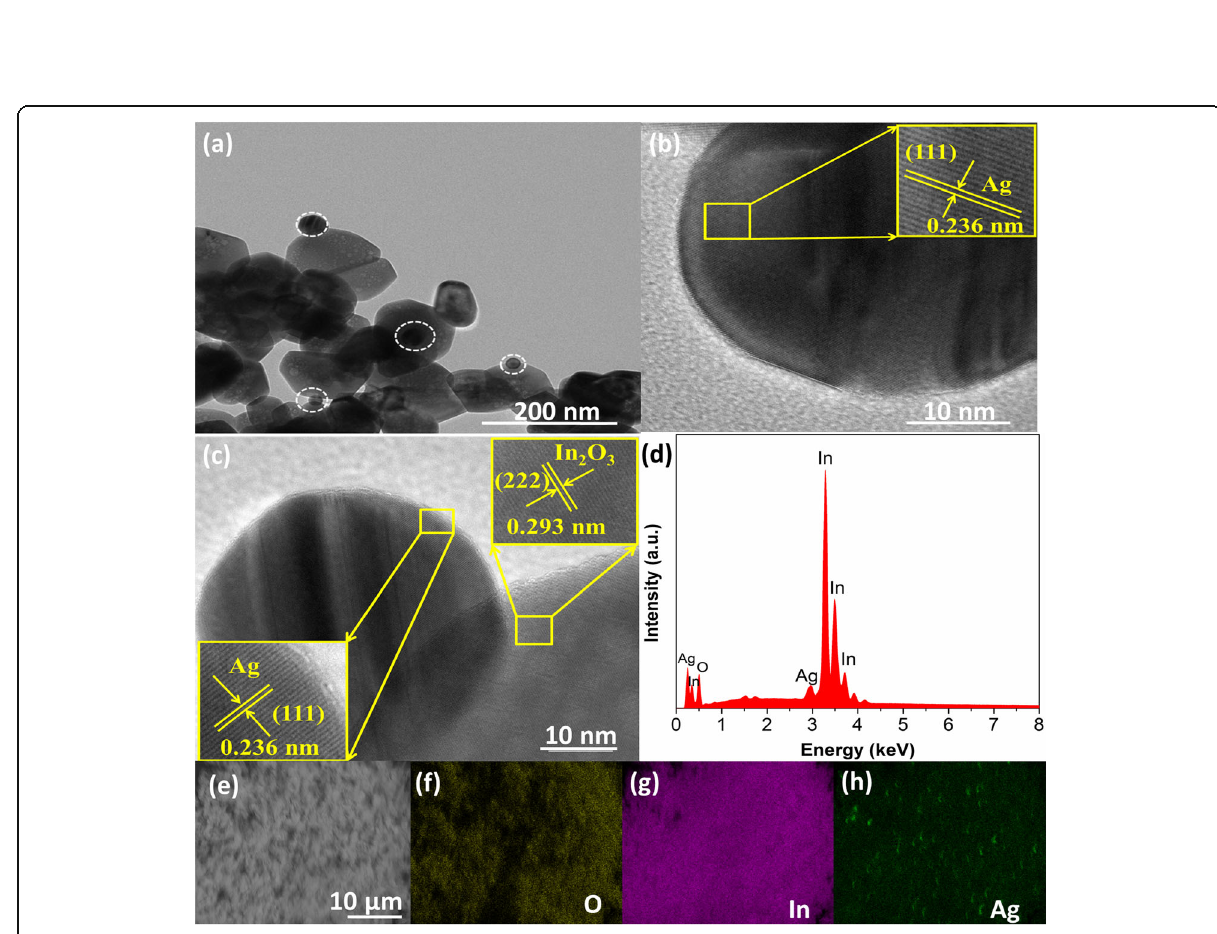
Fig. 5 a TEM image of 5%Ag-In 2 O 3 samples. b , c HRTEM images of 5%Ag-In 2 O 3 samples. d EDS spectra pattern of 5%Ag-In 2 O 3 samples. e – h The EDS mapping picture of O, In, and Ag elements of 5%Ag-In 2 O 3